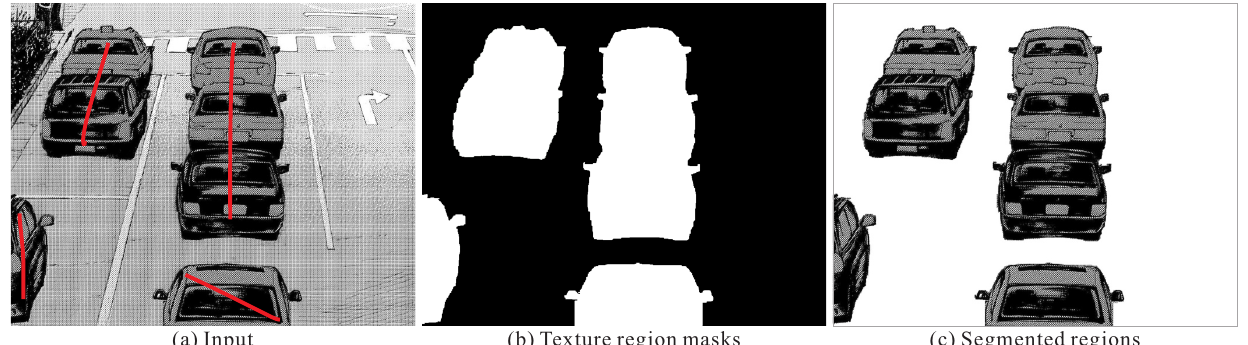
Fig. 11 ‘Cars’ (762 × 843, loading time: 4.03s, processing time: